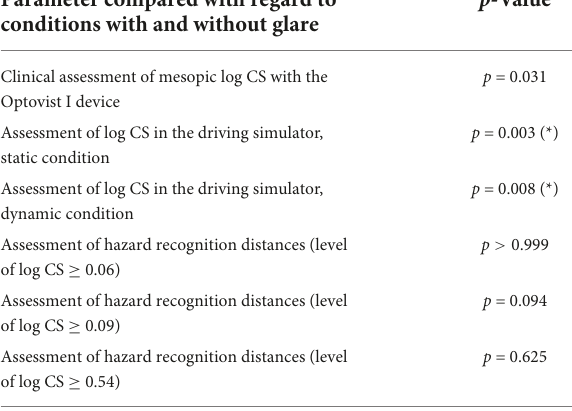
TABLE 2 Results of pairwise Wilcoxon tests for the comparison of conditions with and without glare. Parameter compared with regard to conditions with and without glare Clinical assessment of mesopic log CS with the Optovist I device Assessment of log CS in the driving simulator, static condition Assessment of log CS in the driving simulator, dynamic condition Assessment of hazard recognition distances (level of log CS ≥ 0.06)